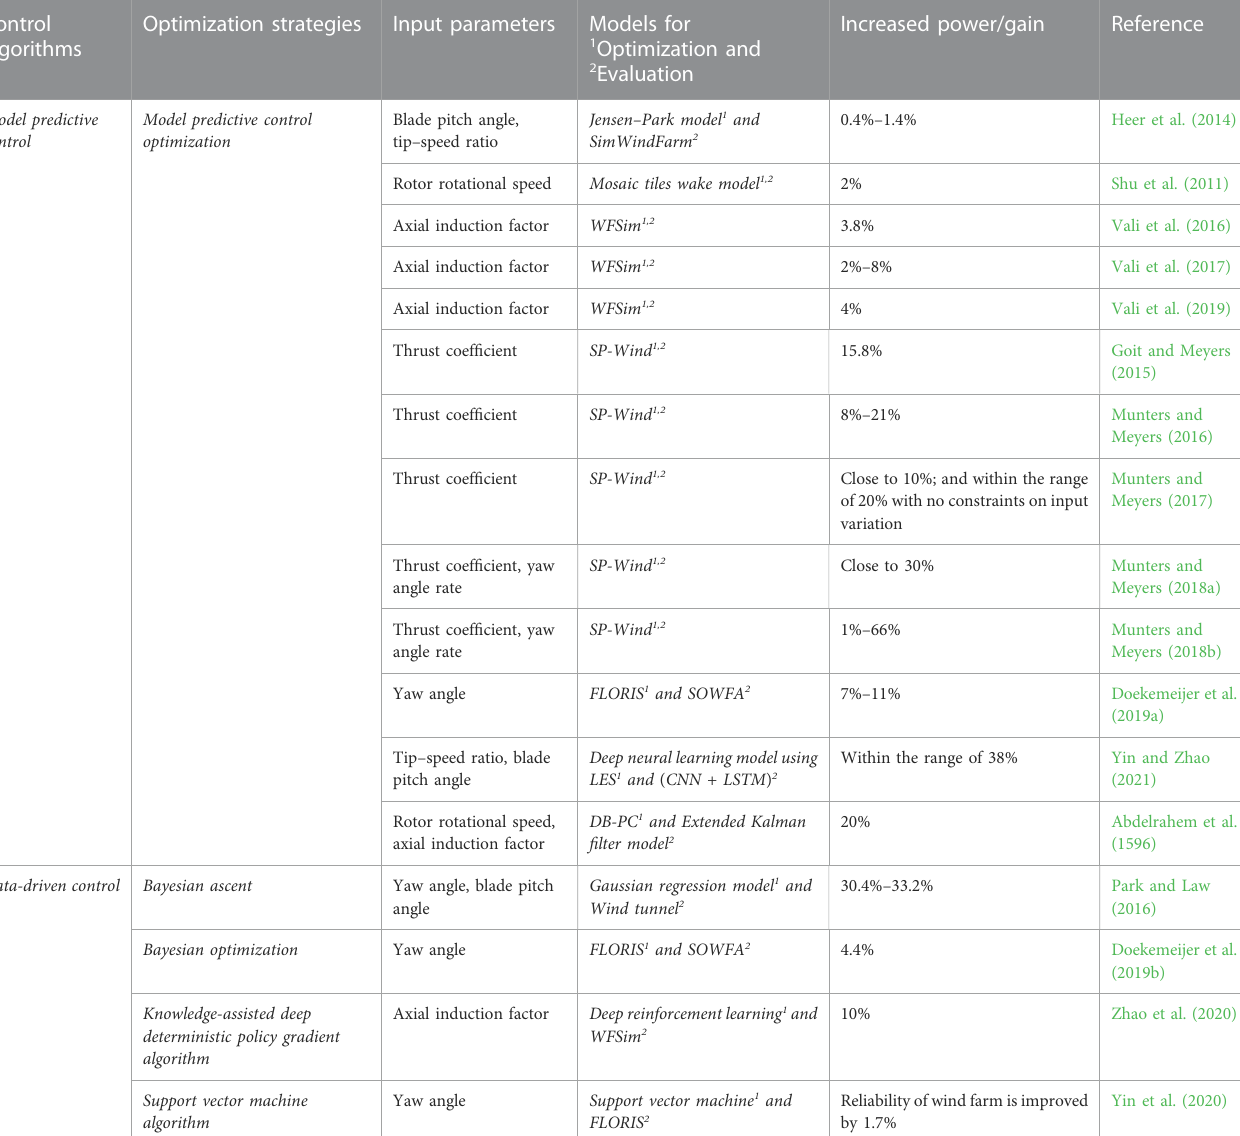
TABLE 6 Performances of model-based closed-loop control strategies with different optimization and evaluation